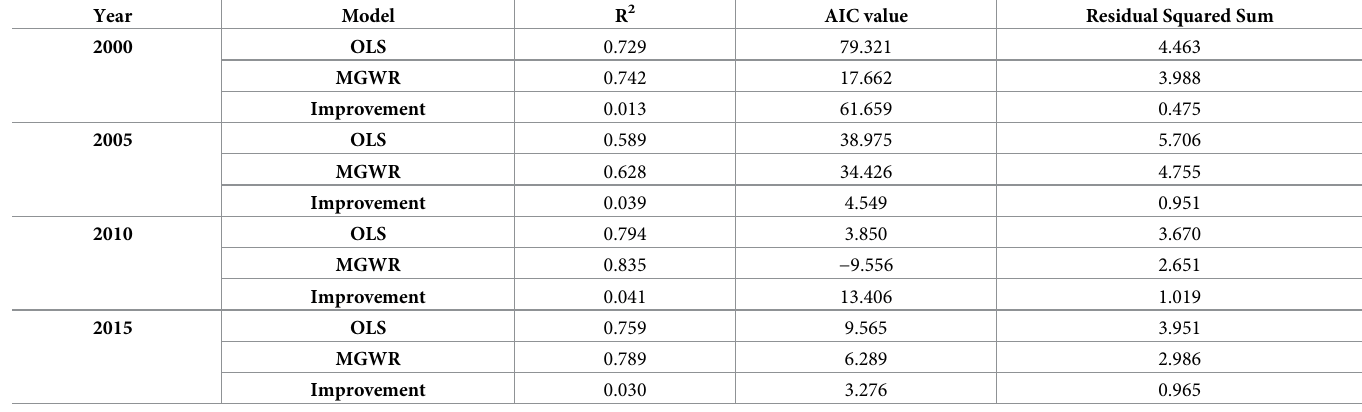
Table 4. Comparison of the OLS regression model and the MGWR model